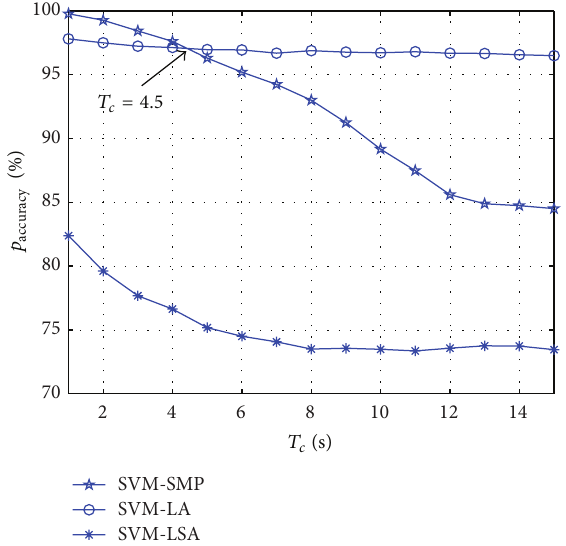
Figure 4: Prediction accuracy rate 𝑝